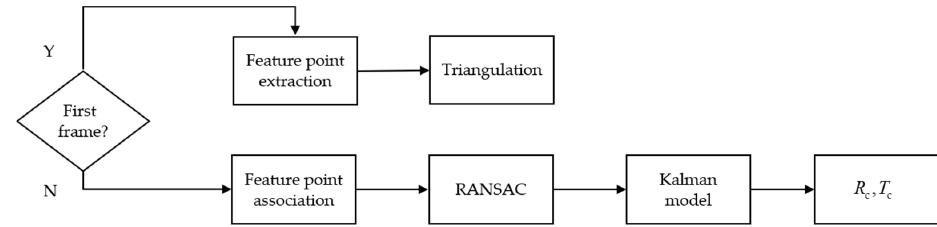
Figure 7. Flow chart of the initial pose acquisition phase. (a) For the first frame, the feature point extraction is performed in the left and right im- ages. A set of feature point pairs is obtained through brute force matching and the epipolar constraint criterion between the left and right cameras. Its three-dimen- sional coordinates in the left camera coordinate system are calculated through the principle of triangulation. (b) For a non-first frame, the number of feature points will decrease if the optical flow tracking time is too long. If the number of feature points tracked in the current frame is less than threshold N T (since perspective-n-point problems require at least 3 sets of points, the threshold should be greater than 3, which was set as 6 in this manuscript) , then this frame adopts the method of the first frame to add new feature points. After obtaining the 3D set in the left camera coordinate system of the previous frame and the 2D feature point set of the left image in this frame, the rotation matrix and translation vector are solved quickly based on the random sample consensus (RANSAC) [27] method. (c) Since the surface of a non-cooperative spacecraft has multilayer reflective materials, the texture information is relatively lacking, which leads to the appearance of outliers in the binocular measurement process. A Kalman filter model [28] was introduced to eliminate the outliers and ensure the stability of the system in this paper. Assuming that the acceleration of the tracking spacecraft relative to the target space- craft is constant, the geometric kinematics between the two spacecrafts is modeled. The state and observation of the system can be represented as: 1